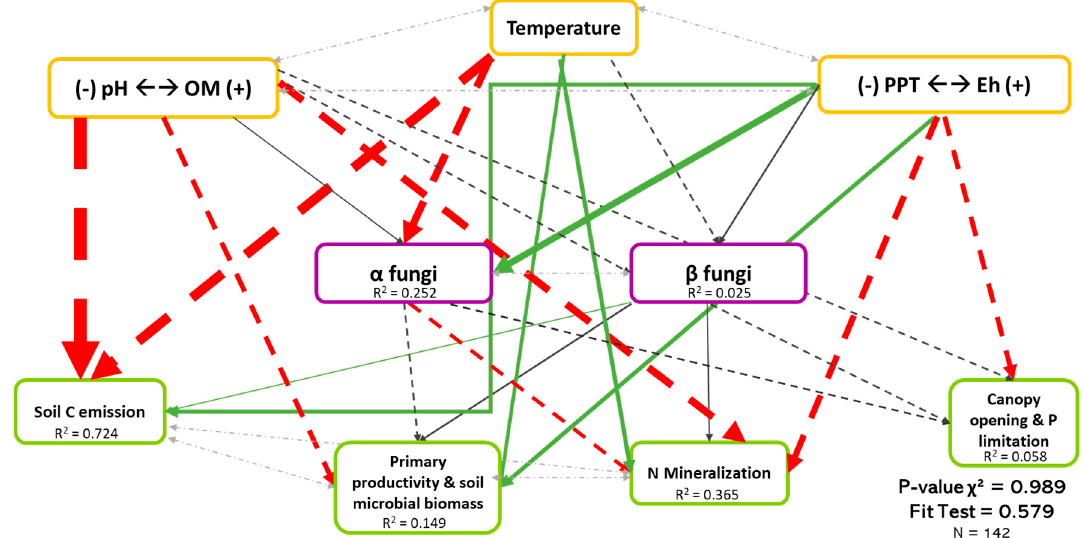
Figure 4. Causal relationships between abiotic variables, fungal diversity, and ecosystem functioning. Structural equation model of boreal forest ecosystems in Quebec. The direction of the arrows indicates the direction of the regression existing between the variables. The solid (green) arrows represent a positive correlation, while the dotted (red) arrows represent negative correlations ( Supplementary Material Table S3.1 ). The small pale gray arrows show the covariation. The black arrows are the nonsignificant correlations at a threshold of 0.1. The thickness of these arrows represents the strength of the correlation. The R 2 shows the proportion of the variance explained for each variable and the model's P-value and fit test indicate the acceptability of the model. The strongest relationships are between organic matter (and pH) and temperature-related variables and the soil C emission. n = 142 .